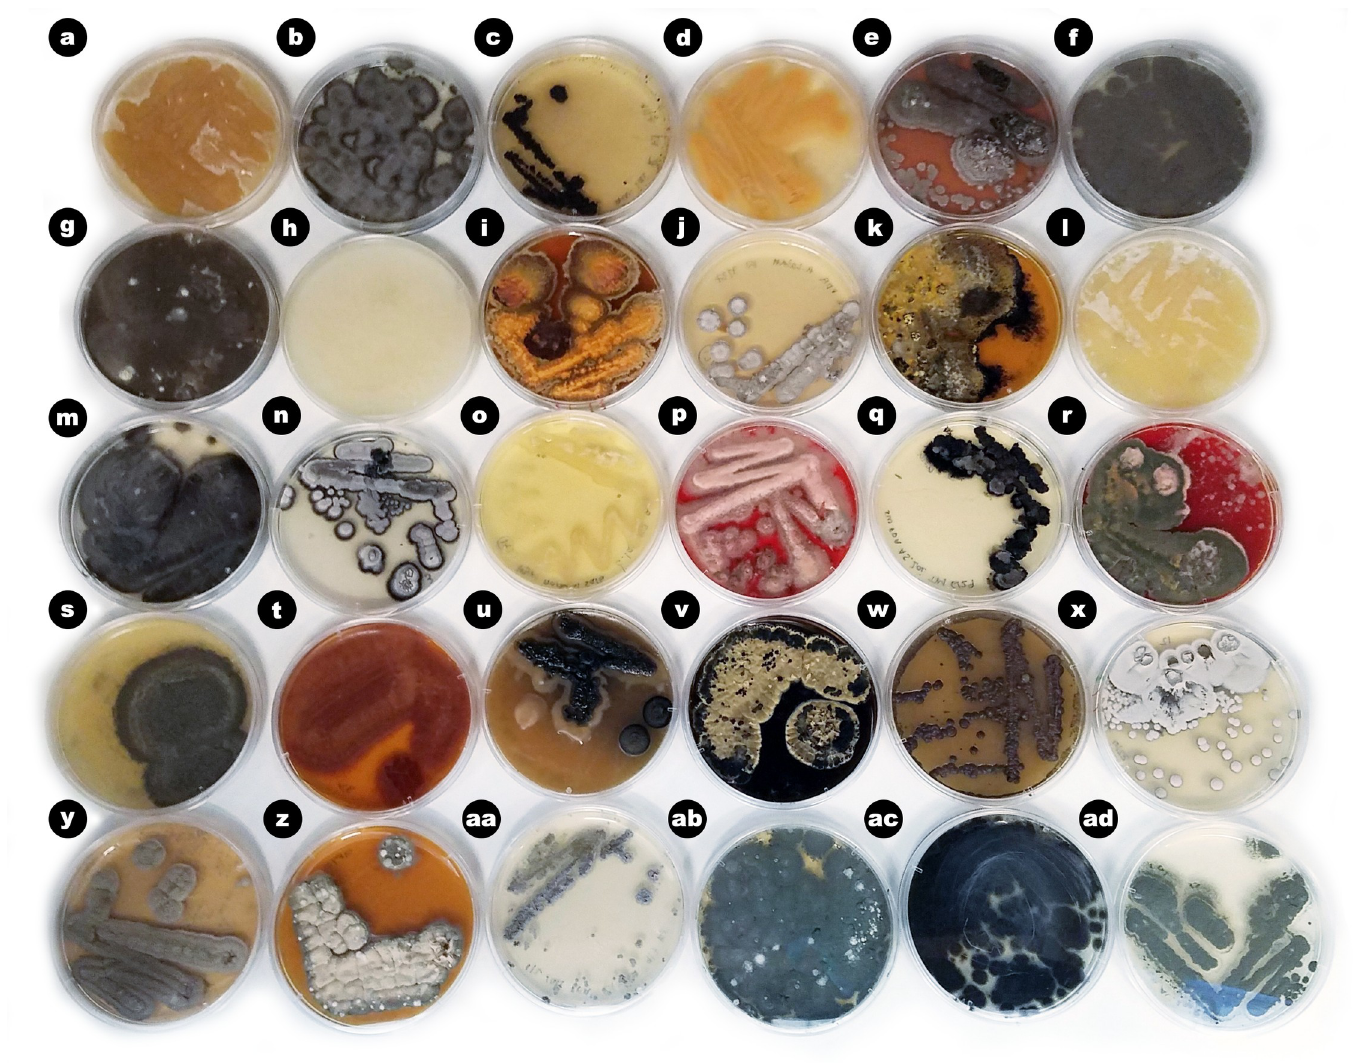
Fig 1. Microbes isolated from the seagrass, Zostera marina . An example of the morphological diversity of microbial isolates (bacteria, fungi and oomycota) associated with the seagrass, Z . marina . Depicted plates were arbitrarily chosen to depict the morphological diversity of the isolates cultured in this study. Putative taxonomy of isolates shown: (a) Penicillium sp. CLE73, (b) Cladosporium sp. CLE116, (c) Colletotrichum sp. CLE5, (d) Hypocreales sp. CLE105, (e) unidentified microorganism, (f) Penicillium sp. CLE130, (g) Penicillium sp. CLE68, (h) Halophytophthora sp. CLE94, (i) Pleosporales sp CLE57, (j) unidentified microorganism, (k) Pleosporales sp. CLE102, (l) Penicillium sp. CLE26, (m) Cladosporium sp. CLE118, (n) Ramularia sp. CLE122, (o) Pseudoalteromonas sp. CLE126, (p) Talaromyces sp. CLE92, (q) Colletotrichum sp. CLE4, (r) Talaromyces sp. CLE82, (s) unidentified microorganism, (t) Acrostalagmus sp. CLE7, (u) Ramularia sp. CLE1, (v) Pleosporales sp. CLE56, (w) Penicillium sp. CLE77, (x) Ramularia sp. CLE112, (y) Penicillium sp. CLE106, (z) unidentified microorganism, (aa) Streptomyces sp. CLE117, (ab) Penicillium sp. CLE114, (ac) Cladosporium sp. CLE127, and (ad) Penicillium sp. CLE110. Unidentified microorganisms were unable to be identified using molecular methods (i.e. a PCR product was not successfully